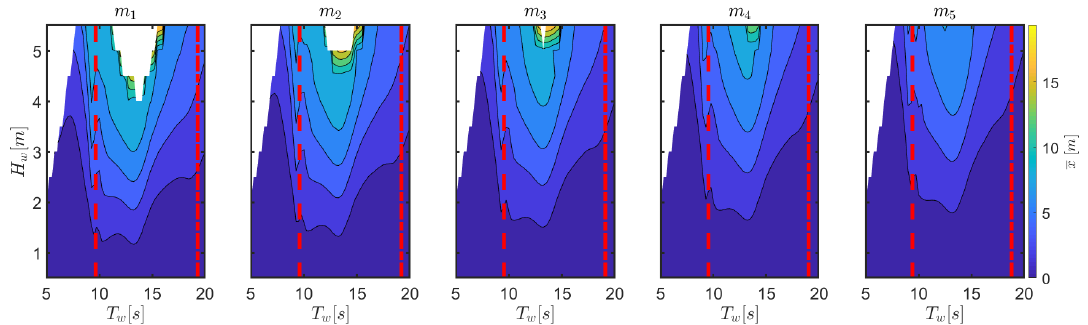
Figure 9. Mean displacement in surge x due to drift effects as a function of T w and H w , for different mooring configurations. The dashed and dash-dotted red lines correspond to T w = 1 respectively.